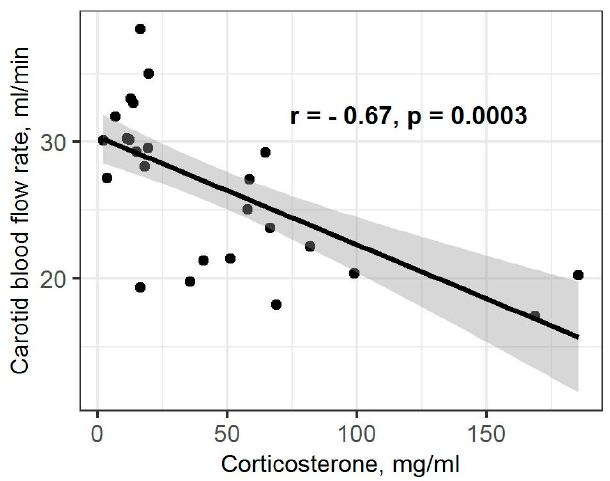
Figure 5. Spearman correlation between blood flow rate and plasma CORT levels in PSS rats. Gray area around the line represents the 95% confidence interval.